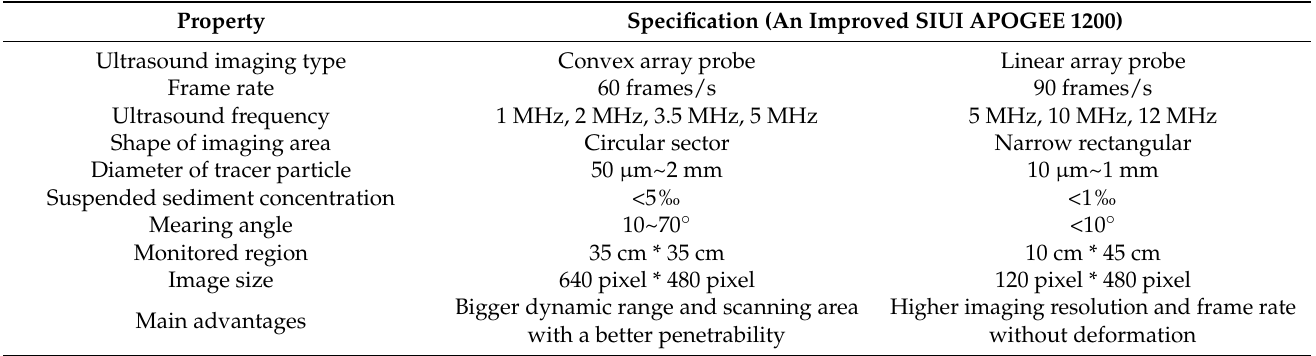
Table 1. Properties and specifications of the experimental device.